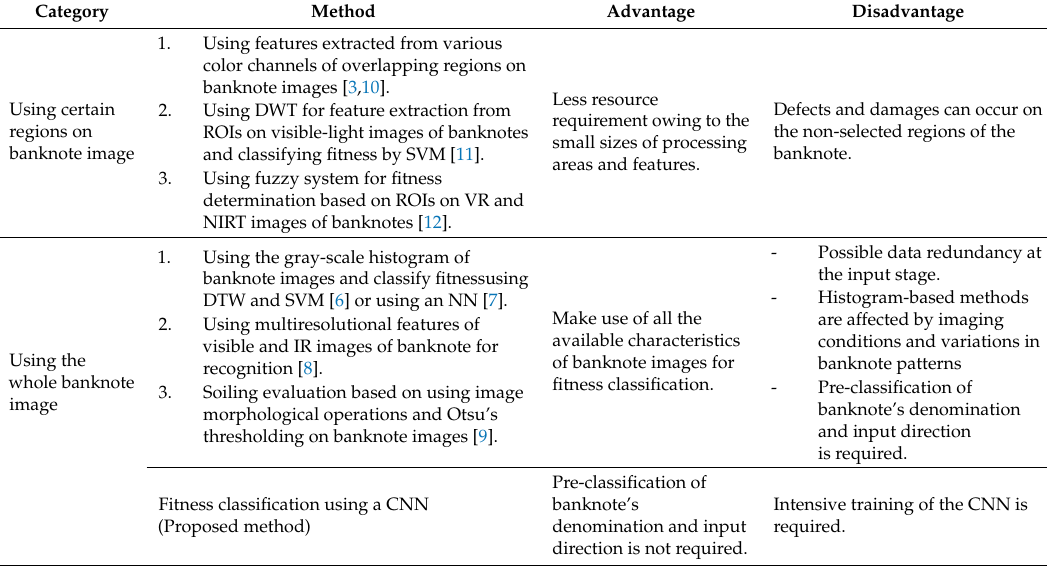
Table 1. Comparison of the proposed method and previous works on the fitness classification of